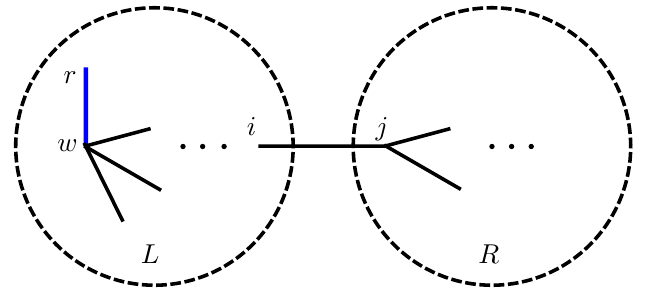
Figure 4. Illustration for a Cayley graph and the rewriting of scattering